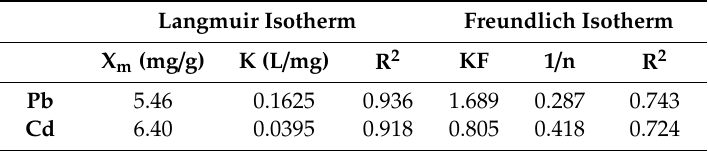
Figure 8. Langmuir and Freundlich isotherms of Pb and Cd ions, 0.10 g Phragmites powdered biomass, Table 2. Langmuir and Freundlich isotherm model constants for the adsorption of Pb (II) and Cd (II) ions.